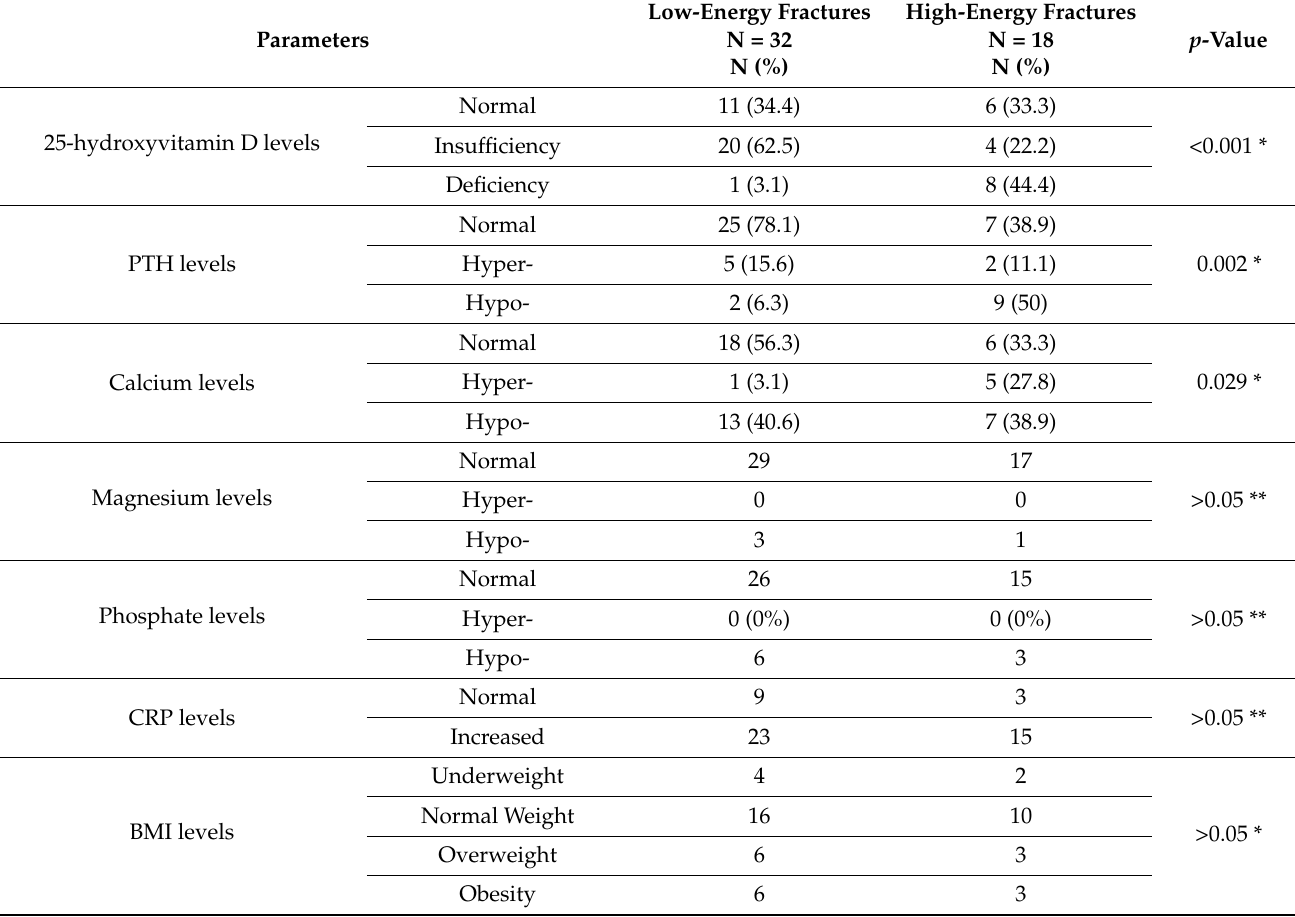
Table 2. Frequencies of the tested variables with regards to low-energy and high-energy fractures.